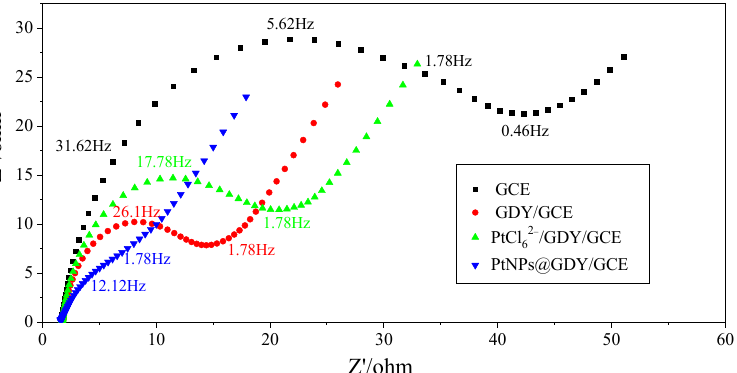
Figure 2. The impedimetric characteristics of bare GCE, GDY/GCE, PtCl 62 − /GDY/GCE, and PtNPs@GDY/GCE.